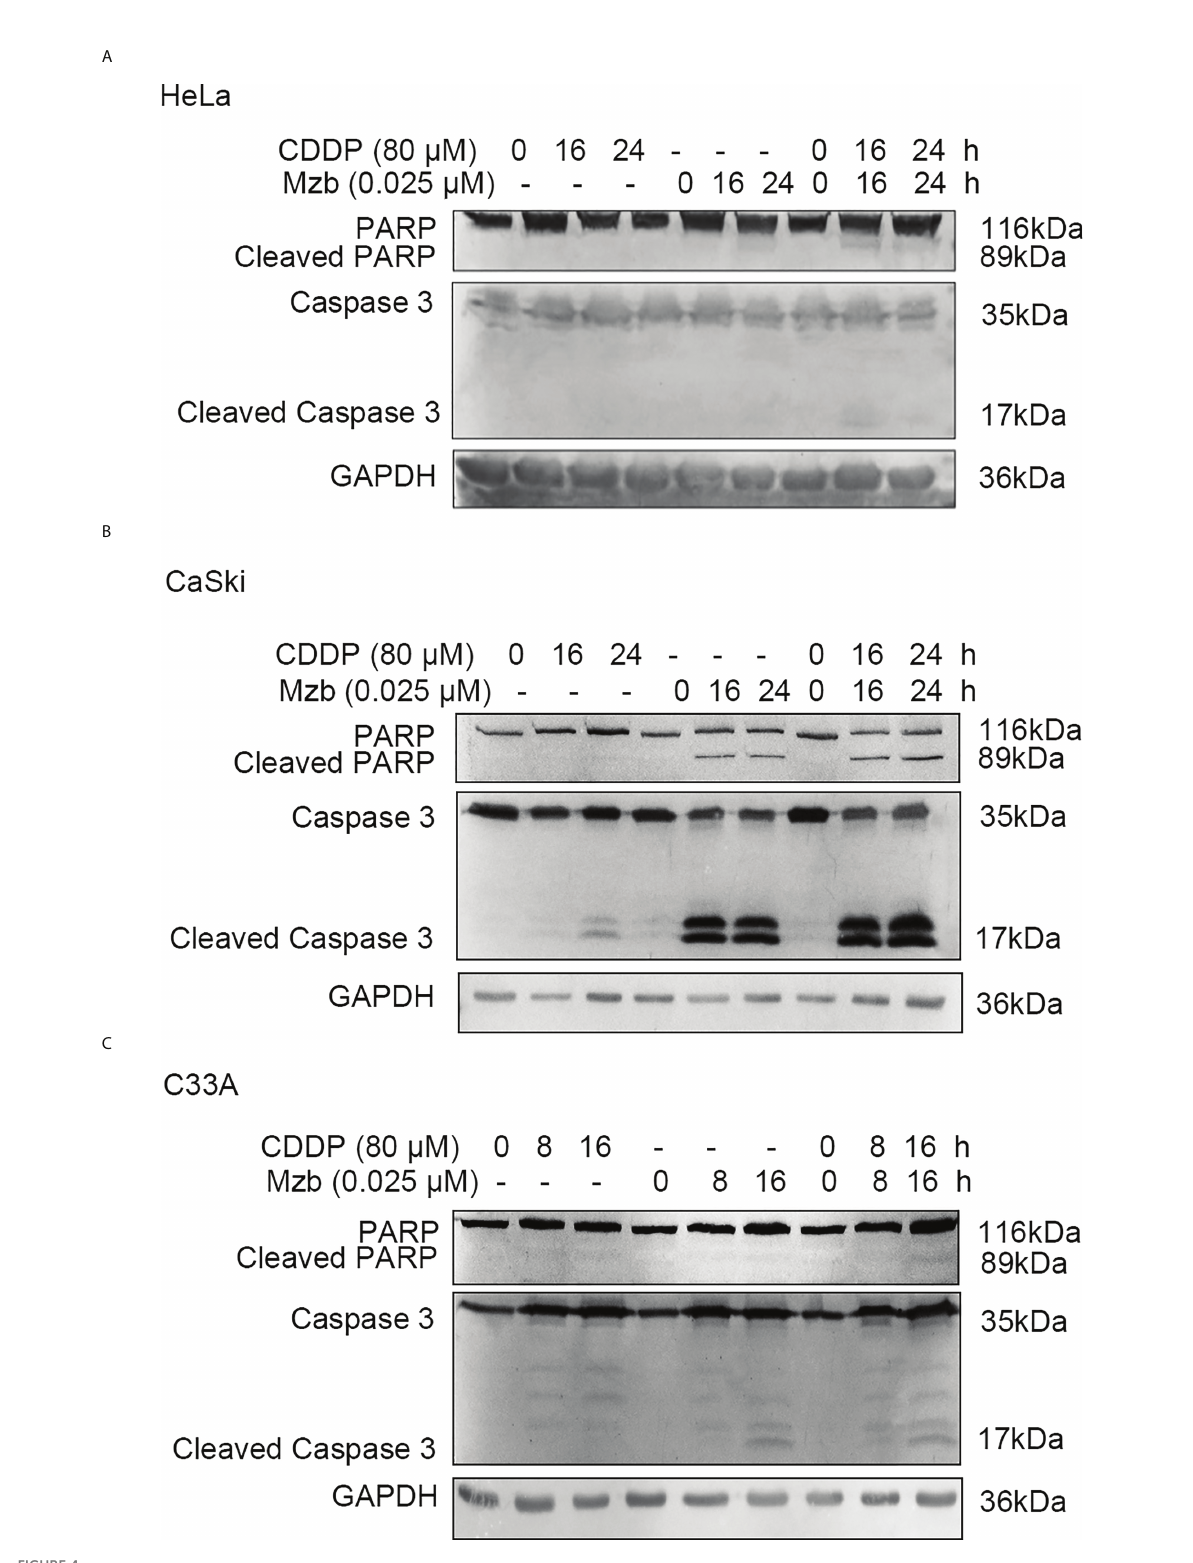
FIGURE 4 Marizomib strengthens CDDP-induced apoptosis in cervical cancer cells. (A – C) The cervical cancer cell lines HeLa and CaSki were treated with CDDP alone (80 m M) marizomib alone (0.025 m M) or the combination of the two drugs for 0, 16 h, or 24 h, and C33A was treated with CDDP alone (80 m M) marizomib alone (0.025 m M) or the combination of the two drugs for 0, 8 h, or 16 h. Then, whole cell lysates were run on SDS − PAGE and immunoblotted with antibodies against PARP and caspase 3 to detect apoptosis. GAPDH was used as the loading